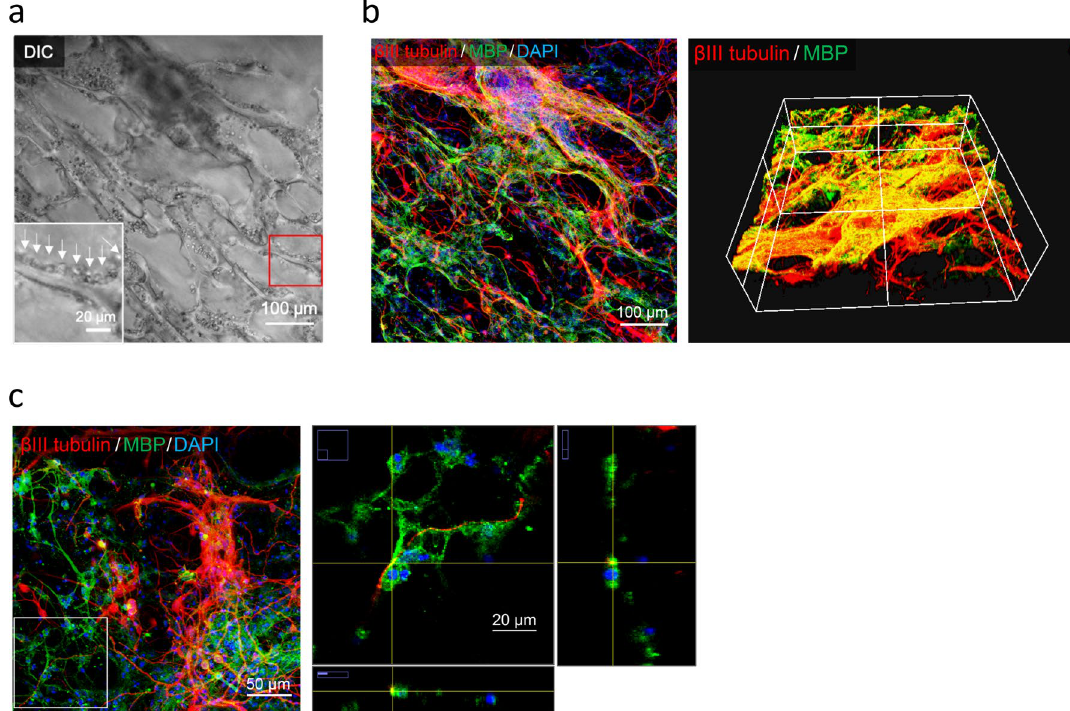
ml) was added daily for the first week, and bFGF was removed for the second week. The inset is a higher magnification of the area in the red square. ( b ) Immunofluorescence image. Three-dimensional cultures of neurons and glial cells were confirmed to stain red for βIII tubulin and green for myelin basic protein. Blue indicates nuclei visualized by DAPI staining. ( c ) Immunofluorescence images of areas of confirmed myelination. The white box indicated in the left panel is magnified and shown as the middle panel. The crossing point of the yellow vertical and horizontal lines is magnified and shown as lower and right panels. White bars indicate 50 μm and 20 μm in the left and middle panels,